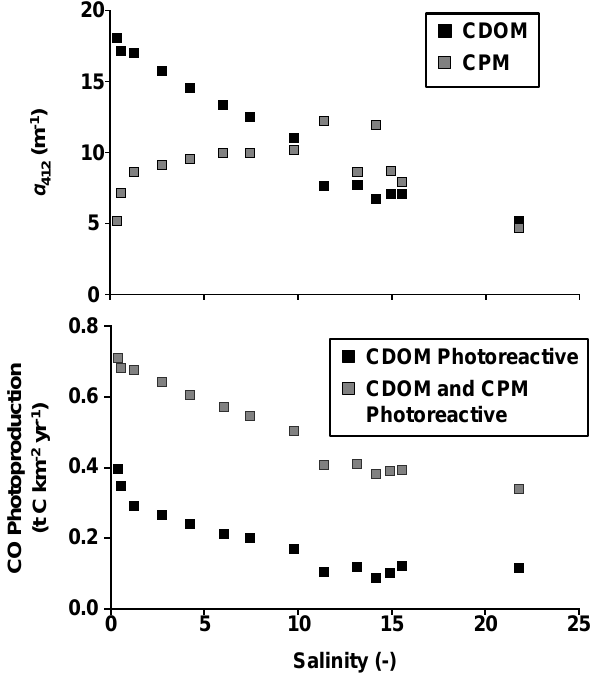
Fig. 6. Top panel: seasonally averaged coloured dissolved organic matter (CDOM; black fill) and particulate coloured material (CPM; grey fill) absorption coefficient at 412nm versus salinity in the Tyne estuary. Bottom panel: seasonally averaged carbon monoxide ver- sus salinity in the Tyne estuary. Black fill: assuming only pho- tons absorbed by CDOM are involved in carbon monoxide (CO) photoproduction; grey fill: assuming all photons absorbed by chro- mophores (i.e.: CDOM plus particulates) are involved in CO pho-